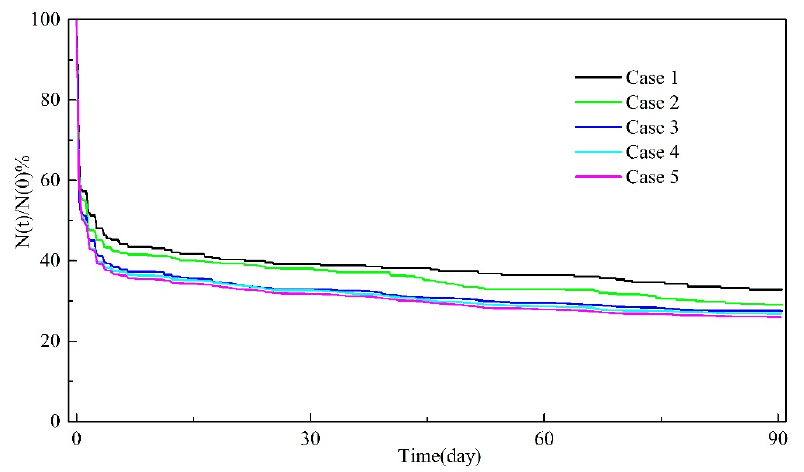
Figure 5. Calculated residence time of different numbers of released particles. Table 1. Different resolution of released particles.